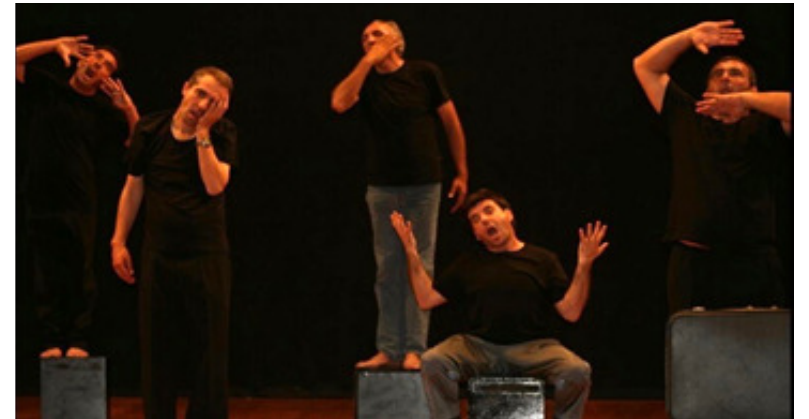
Figure 1. A scene from Tristeza de Mundo in